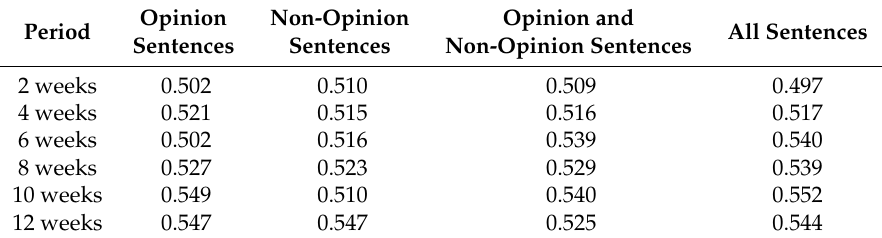
Table 10. Results of the multitask. Macro-F1 is a